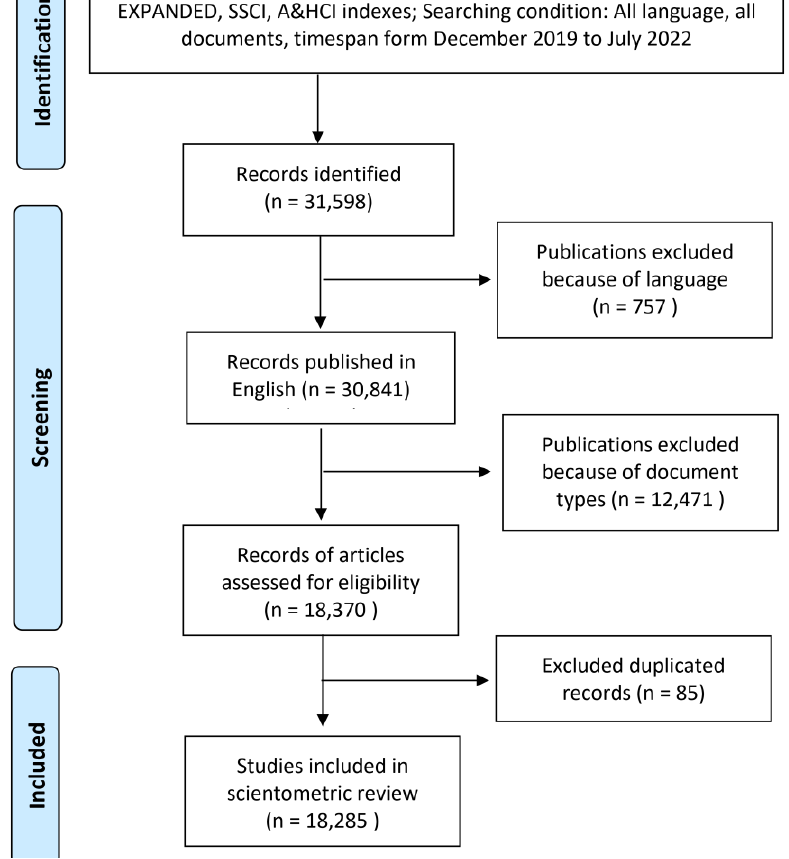
Figure 1. PRISMA flow diagram on COVID-19 vaccine research.